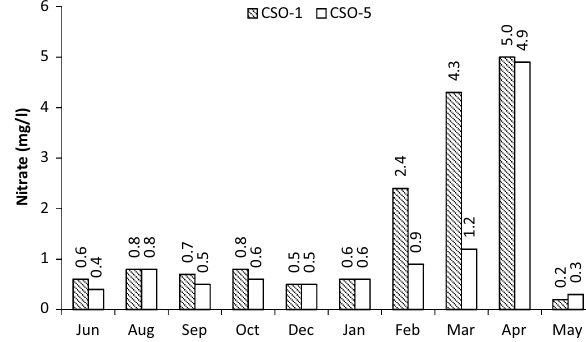
-N, mg/l) at different 3